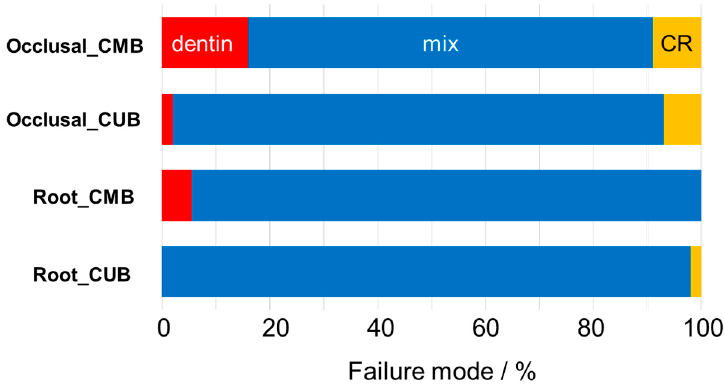
Figure 4. Failure modes. Cohesive failure in dentin (red), mixed failure (blue), cohesive failure in resin (yellow).